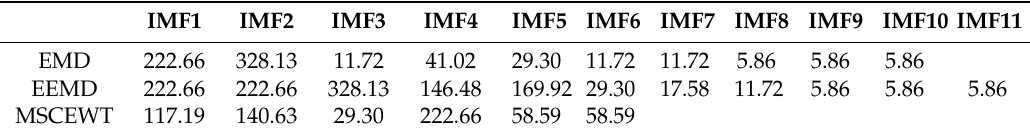
Table 8. The experimental results of roller ball of the motor